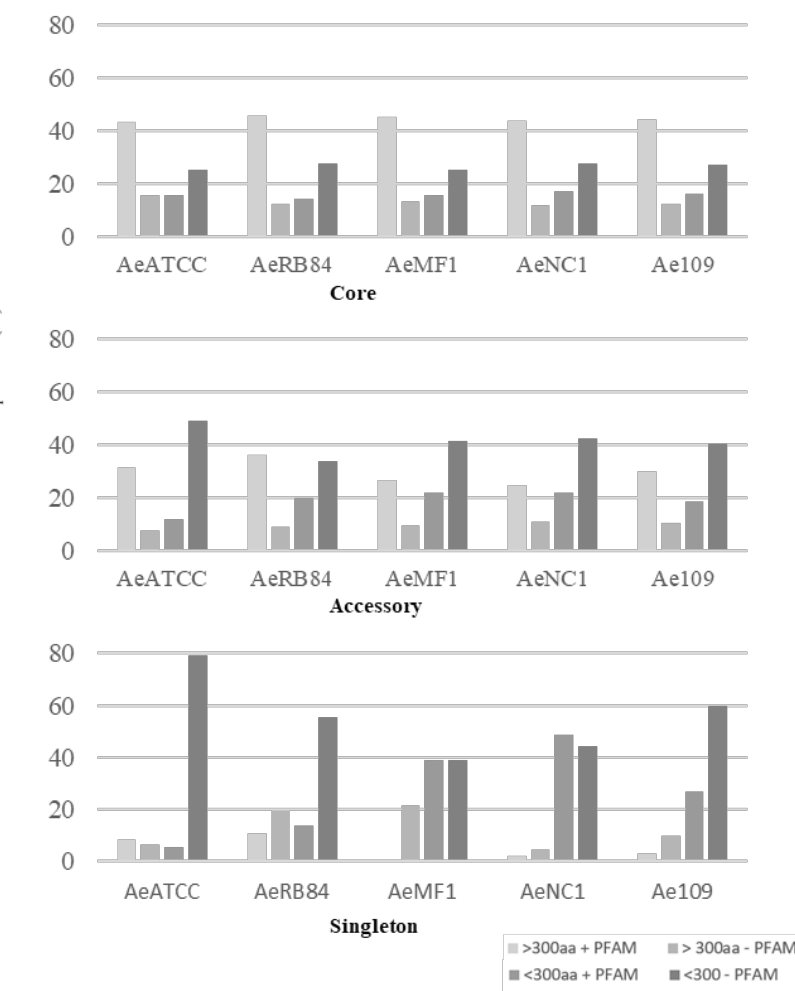
Figure 10. Size distribution of secreted proteins in the core, accessory and singleton secretomes of A. euteiches spp . A. euteiches spp. secreted proteins with (+) or without (-) a predicted PFAM domain are classified in two categories based on their size: larger than 300 amino acids (>300 aa) or less than 300 residues (< 300 aa).